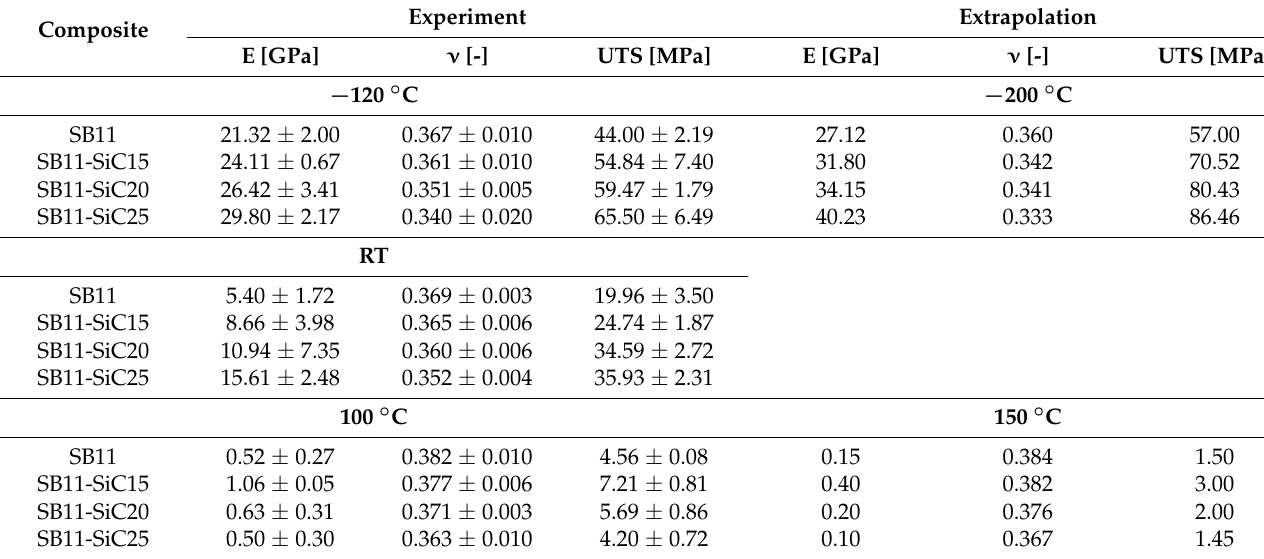
Figure 3. Stress-strain curves obtained from tensile tests for Stycast-SiC composites with different volume fraction of filler at RT. Table 2. Tensile properties of composites specified in FEA.